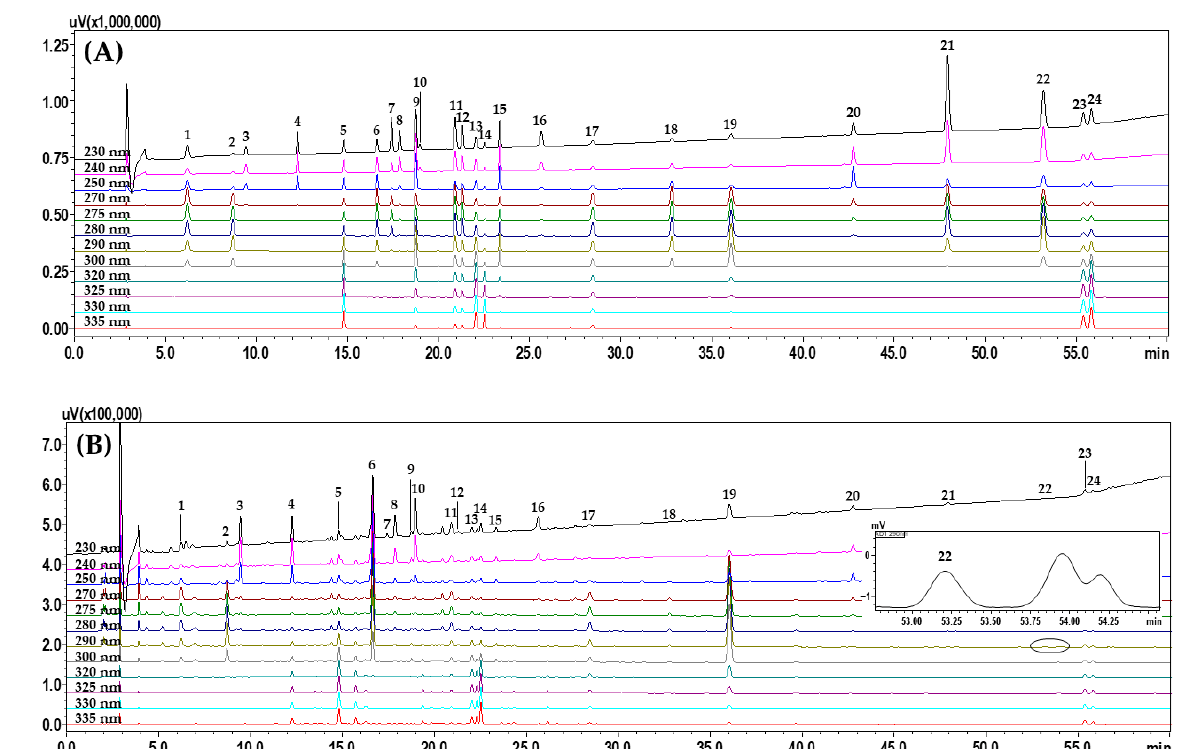
Figure 1. Representative HPLC chromatograms of ( A ) standard solution and ( B ) 70% methanol extract of DHGST sample. Peaks correspond to gallic acid ( 1 ), 5-hydroxymethylfurfural ( 2 ), geniposidic acid ( 3 ), loganic acid ( 4 ), chlorogenic acid ( 5 ), gentiopicroside ( 6 ), pinoresinol diglucoside ( 7 ), albiflorin ( 8 ), prim - O -glucosylcimifugin ( 9 ), paeoniflorin ( 10 ), liquiritin apioside ( 11 ), liquiritin ( 12 ), ferulic acid ( 13 ), nodakenin ( 14 ), 5- O -methylvisammioside ( 15 ), benzoic acid ( 16 ), coumarin ( 17 ), cinnamic acid ( 18 ), cinnamaldehyde ( 19 ), glycyrrhizin ( 20 ), methyleugenol ( 21 ), safrole ( 22 ), decursin ( 23 ), and decursinol angelate ( 24 ).